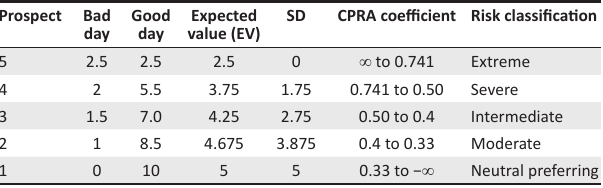
TABLE 1: Round 1: Illustration with upper and lower limits per